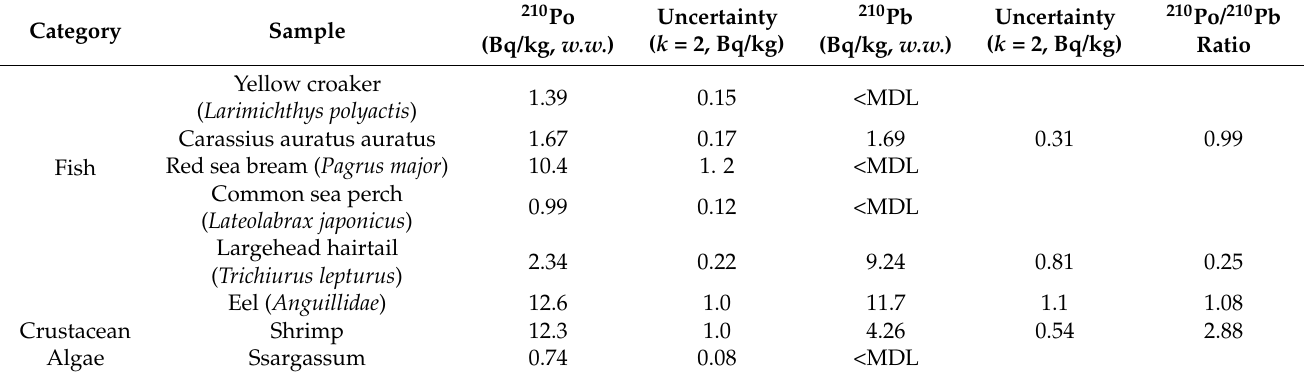
Table 3. Activity concentrations (Bq/kg, w.w. ) of 210 Po and 210 Pb in seafood samples collected from the coast of Fujian, China.